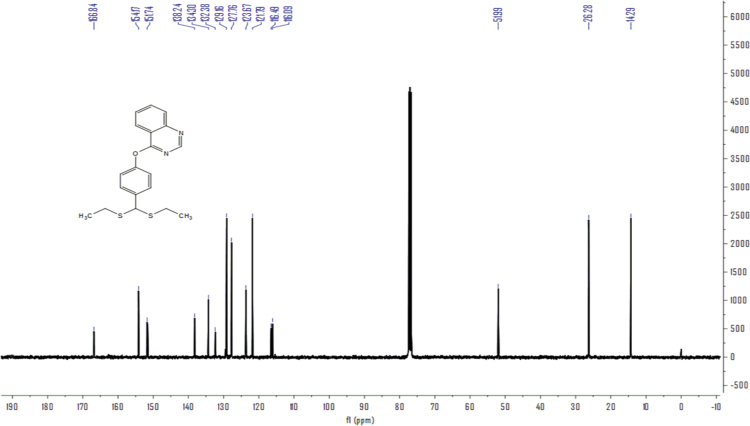
13C NMR of Compound 4a.